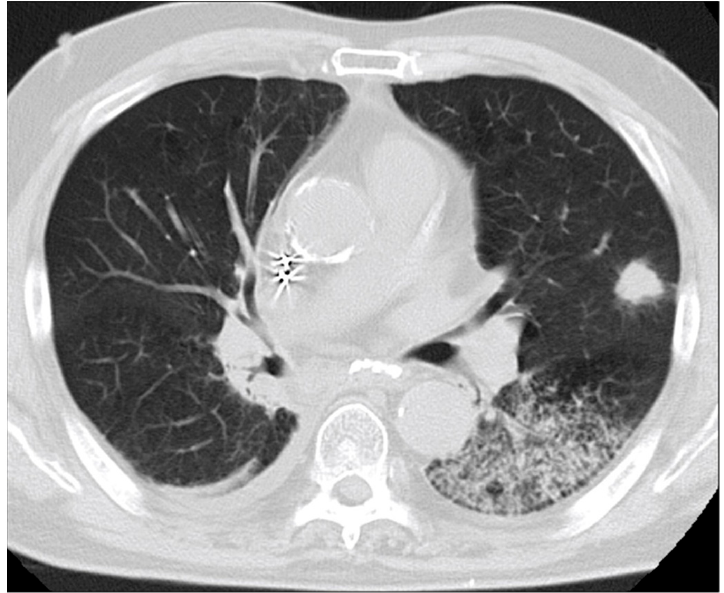
Figure 1. At the time of admission, chest CT showed infiltration shadow in the lower lobe of the left lung and a nodule with irregular margins of 19 mm length in the S4 of the left lung.